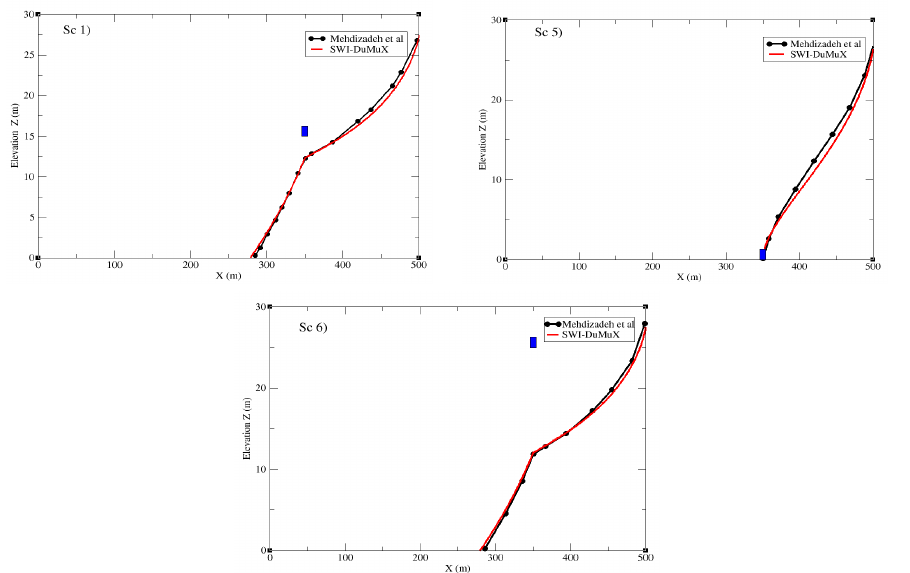
Figure 4. Evolution of the salt front by varying the depth of the well and fixing the pumping rate at 0.1 m 3 /day.